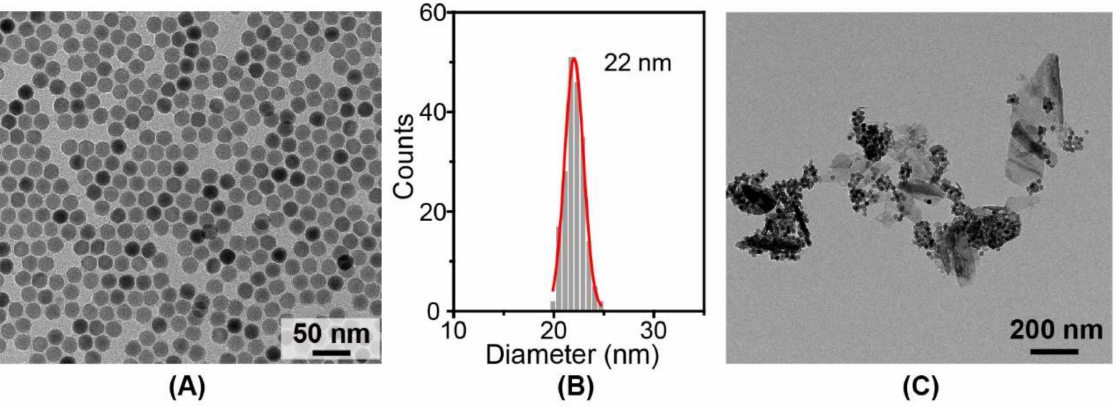
Figure 5. TEM image of OA capped NaYF 4 :Yb,Er (18.2 mol %) nanoparticles ( A ) and the correspond- ing size distribution (B); ( C ) TEM image of BPN@NaYF 4 :Yb,Er (18.2 mol %) nanocomposites.